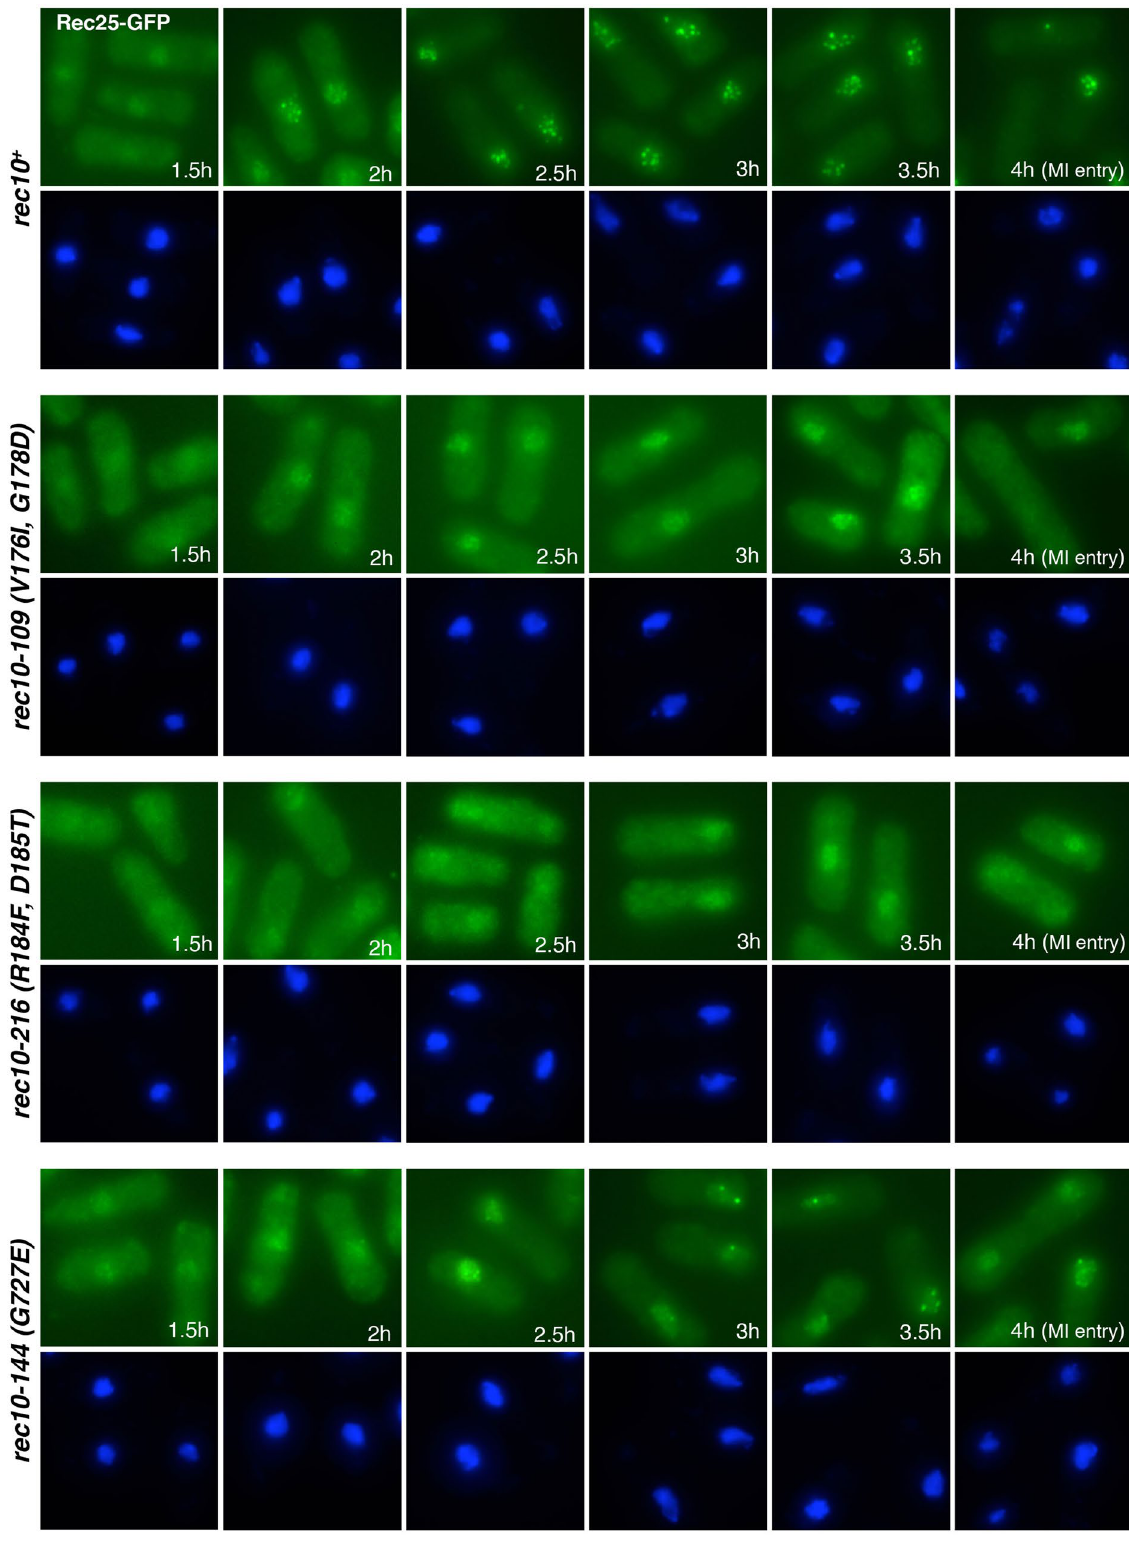
Figure 5. Rec25-GFP localization in rec10 missense mutants. Cells containing Rec25-GFP and the indicated rec10 mutations were induced for meiosis and fixed for fluorescence microscopy. The upper panels show Rec25- GFP, while the lower panels show DAPI-stained DNA. The figures show only the time points when GFP signal was detected (from 1.5 hr to 4 hr) after meiotic